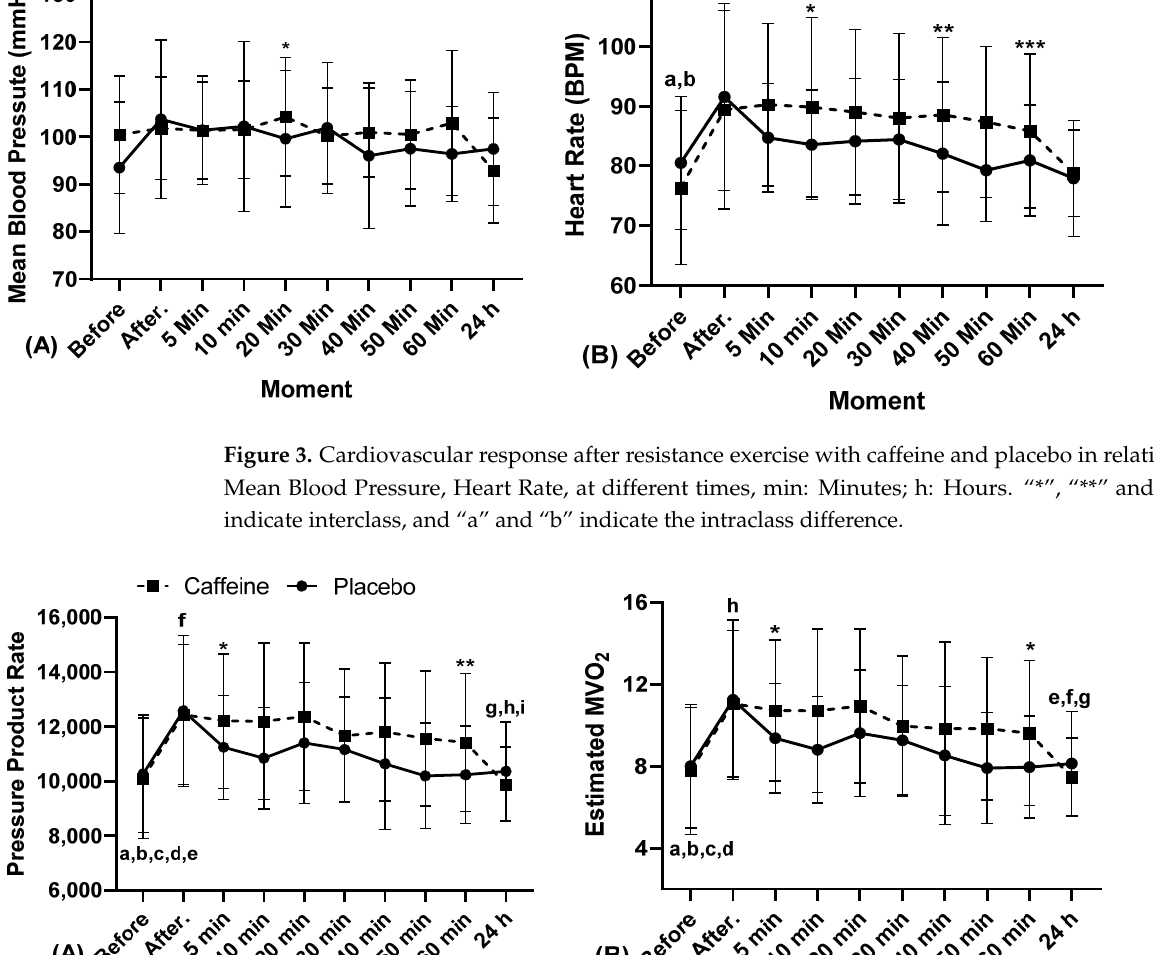
Figure 3. Cardiovascular response after resistance exercise with caffeine and placebo in relation to Mean Blood Pressure, Heart Rate, at different times, min: Minutes; h: Hours. “*”, “**” and “***” indicate interclass, and “a” and “b” indicate the intraclass difference.